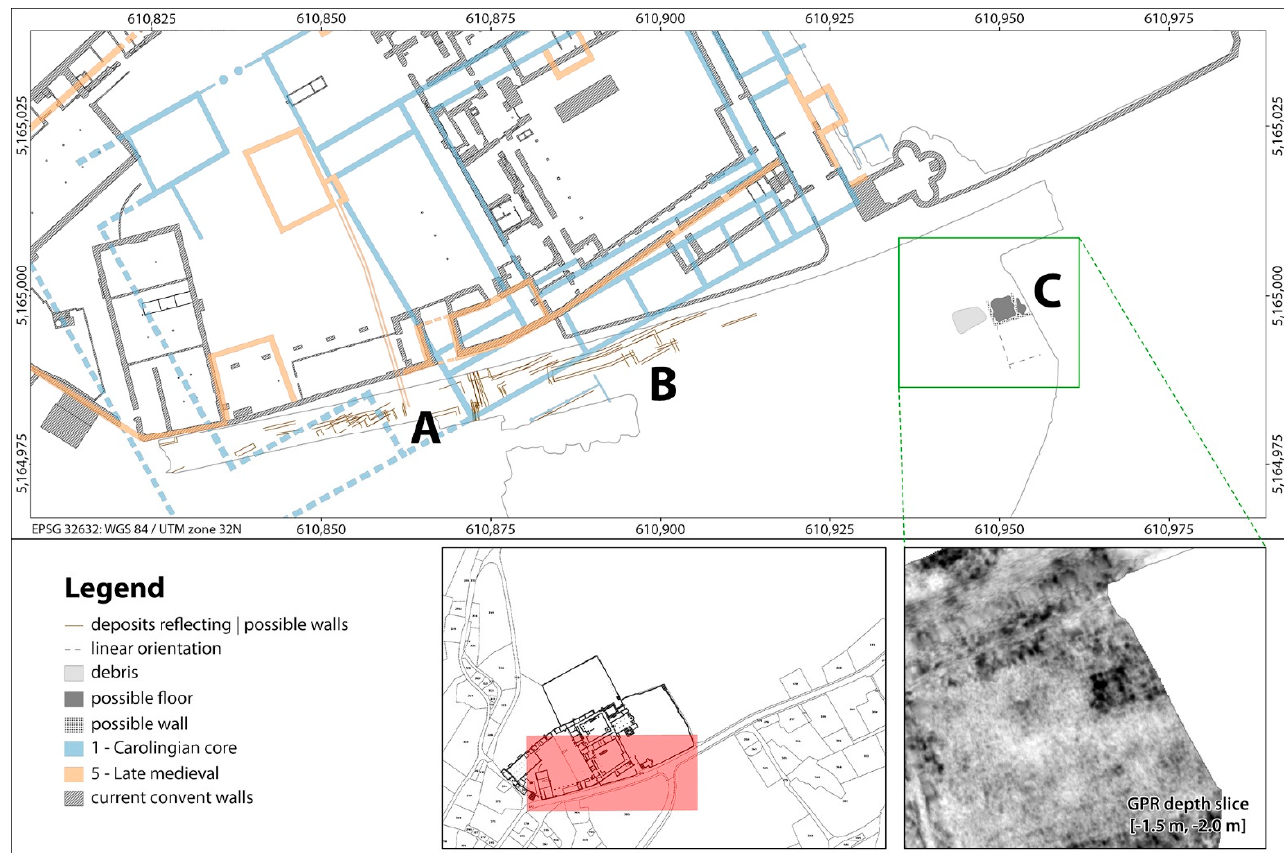
Table 1. Construction periods of the Convent of Saint John (based on [31]). Figure Legend Time